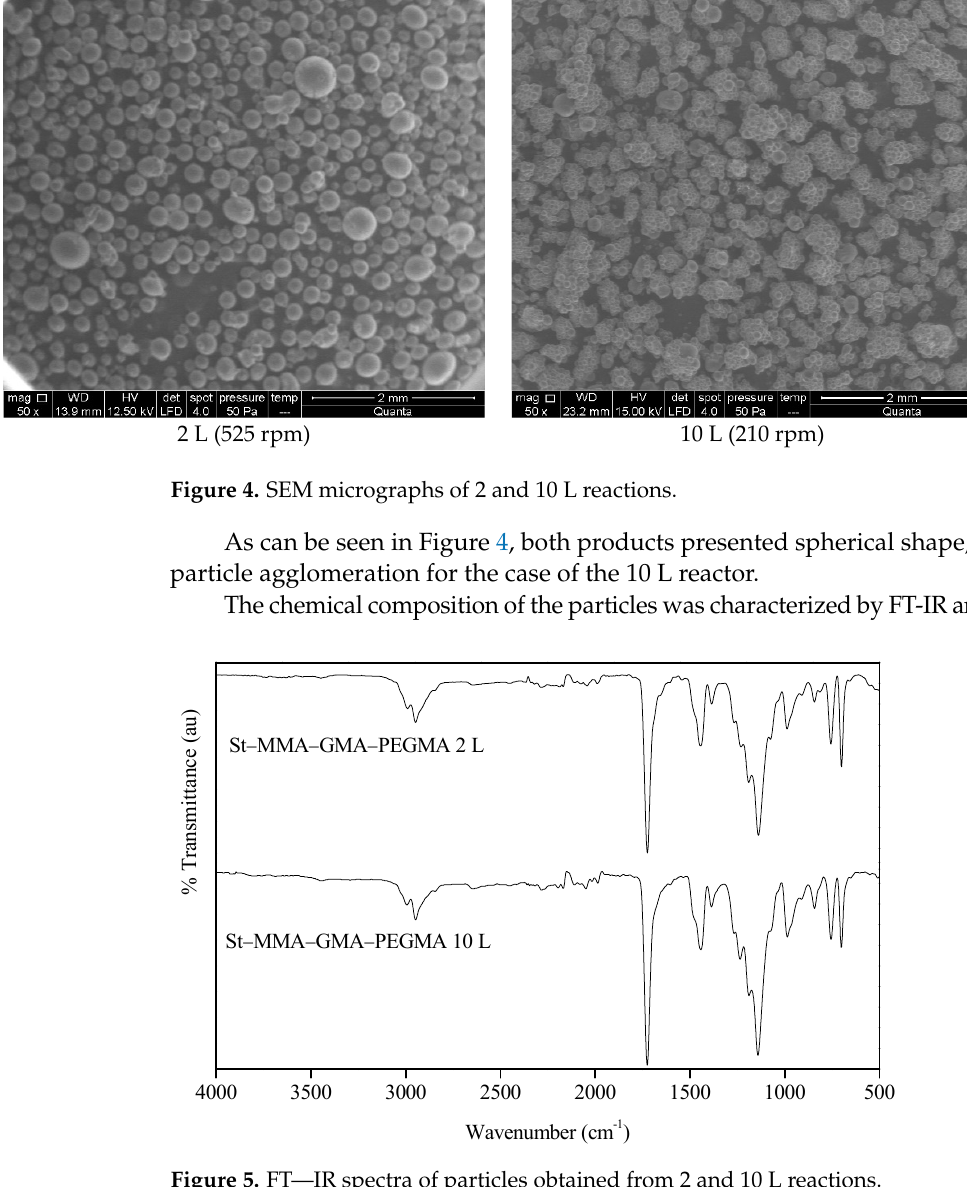
Figure 5. FT—IR spectra of particles obtained from 2 and 10 L reactions. FT—IR results of particles from both scales presented the same absorption peaks.